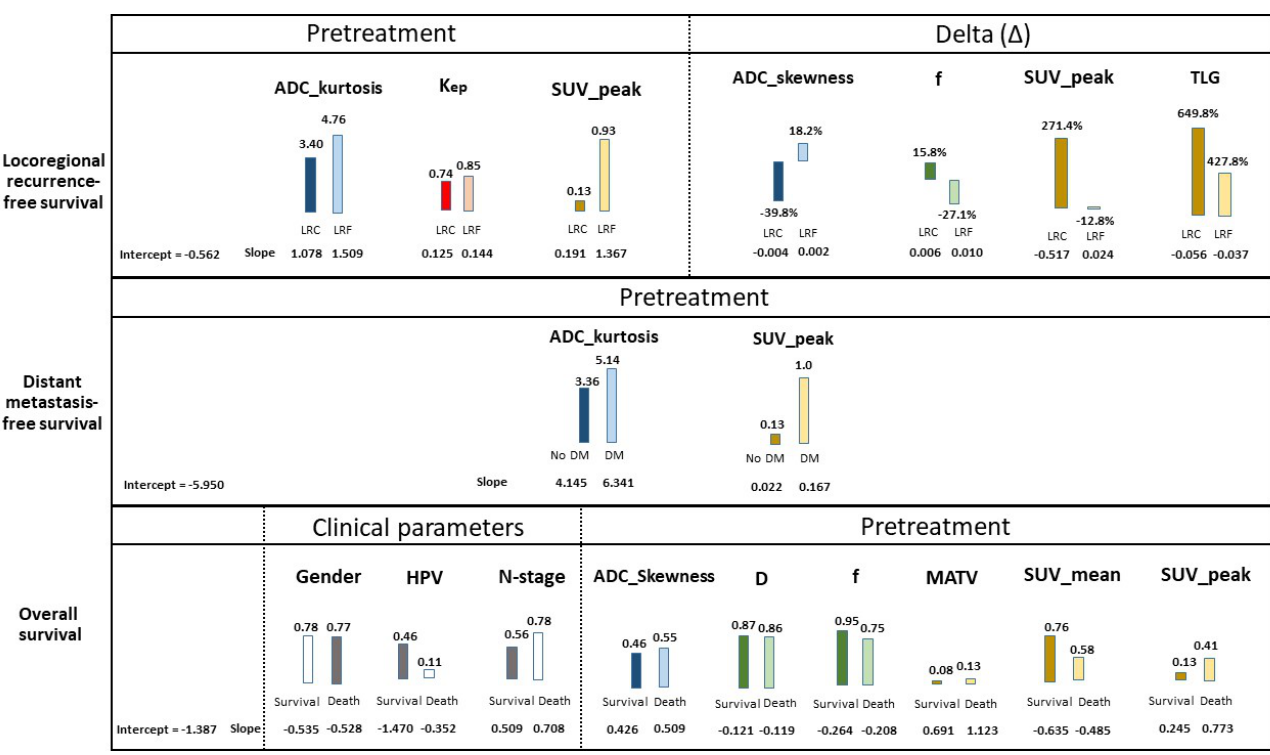
Figure 4. Significant multivariate prognostic pretreatment, intratreatment and delta parameters of all imaging techniques combined for locoregional recurrence-free survival, distant metastasis-free survival and overall survival (See Tables S2 and S3 for the complete tables). Overall, for each patient outcome, the intercept and the slopes per median parameter was shown. The median slopes were found lower in patients with locoregional control (LRC) than locoregional failure (LRF), lower in no distant metastasis (no DM) than distant metastasis (DM), and lower in survival than death, which resulted in a lower risk for an adverse outcome. HPV-negative tumors were marked with a 0, and HPV-positive tumors with a 1. Gender was marked with a 0 for females and 1 for males. Table 3. Prognostic models (Lasso Cox regression) of the 15 imaging features (Table S3) without and with clinical parameters (Table S2) combined, predicting locoregional recurrence-free survival, distant metastasis-free survival and overall survival (Table S8). The amount of features and the area under the curve (AUC) with the standard deviation (SD) is